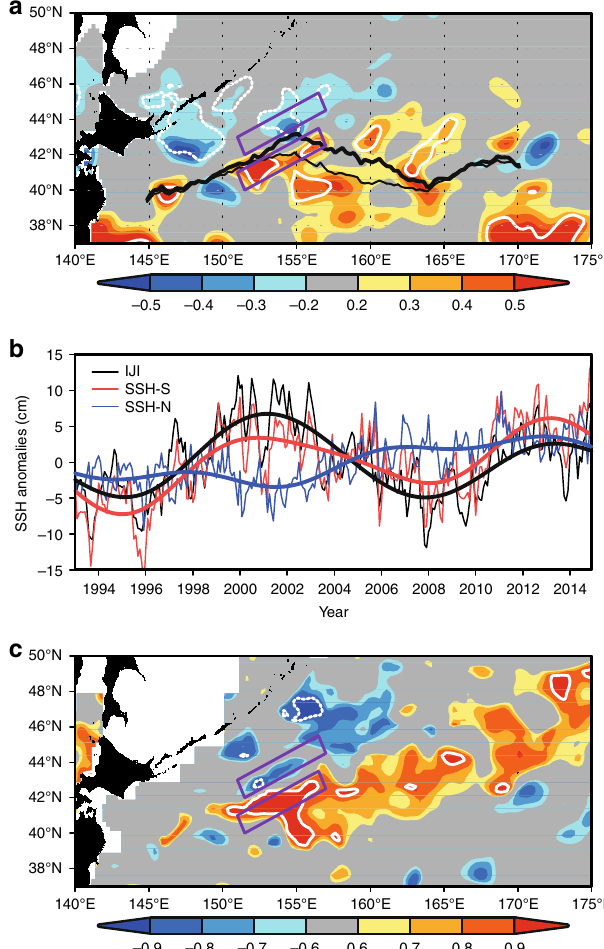
Fig. 2 Isoguchi Jet strength. a Regression map (shade; °C) between SST anomaly (December, January, February) derived from OISST 20 and normalized time series of Isoguchi Jet Index (IJI), where the normalization is made with respect to its standard deviation. Here the IJI is de fi ned by the difference between the satellite derived SSH anomaly 45 in the southeastern box and that in the northwestern box, where de fi nition of each box is given in Methods. White contours denote signi fi cance level greater than 95%. Solid lines denote the SST front latitude Φ ð x Þ þ EOF 1 ð x Þ (cid:3) σ derived from OISST, where σ = 0 (thin line) and σ = 1 (thick line). b Monthly time series of IJI (black), SSH anomaly in the southeastern box (SSH-S; red) and that in the northwestern box (SSH-N; blue). Thick lines denote 7-year low-pass fi ltered time series. c Correlation map between low-pass fi ltered (>7 years) SSH anomaly and normalized IJI time series. White contours denote signi fi cance level greater than